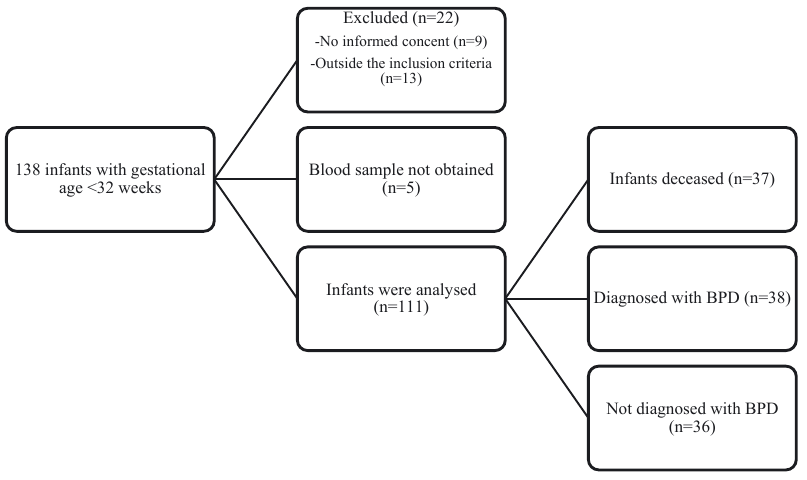
Figure 1: Research fl owchart.